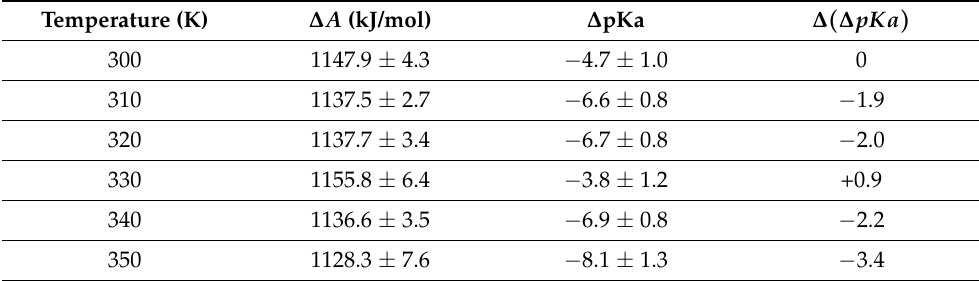
Table 4. Effect of the temperature on the Helmholtz Free Energy change and pKa for Cysteine 35 in TRX, in the range of 300 to 350